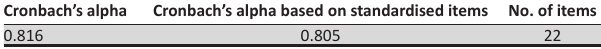
TABLE 1: Reliability statistics